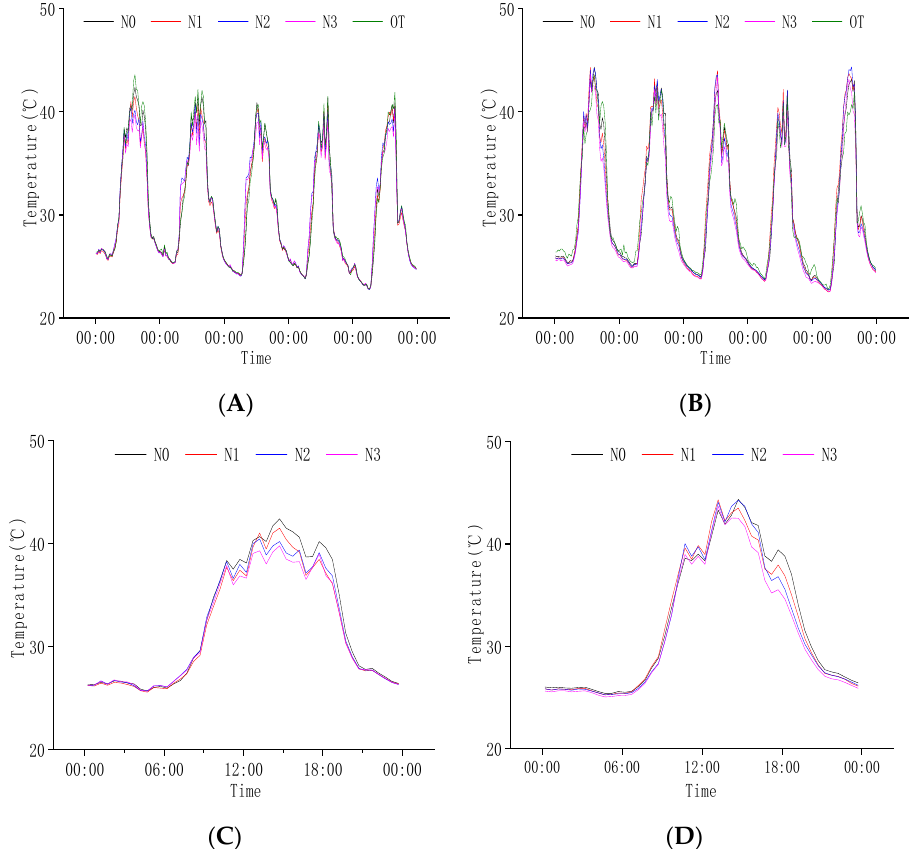
Figure 2. Variation in population temperature at heading stage. ( A ) Canopy population temperature from 26 July to 30 July. ( B ) Baselayer temperature of the population from 26 July to 30 July. ( C ) Canopy temperature of the population on 26 July. ( D ) Baselayer temperature of the population on 26 July. OT is the change in external temperature, N0, N1, N2, and N3 are the effects of different nitrogen fertilizers on population temperature under P1 conditions.